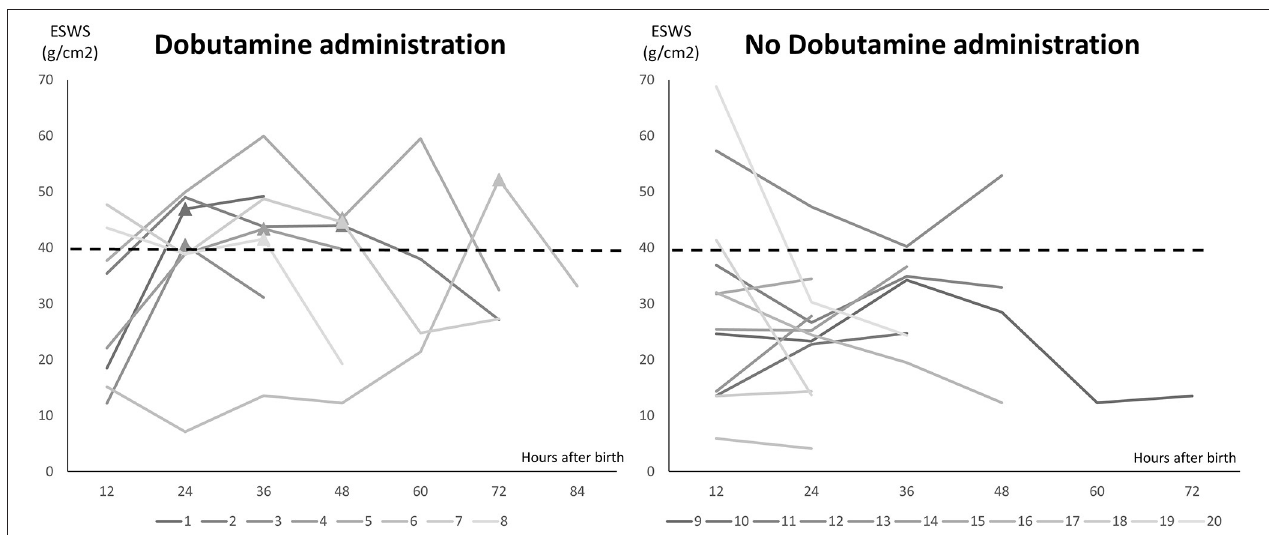
FIGURE 3 | Longitudinal values of ESWS in the management group. Twenty cases were divided into two subgroups: 8 cases with Dobutamine administration and 12 cases without Dobutamine administration. X-axis showed hours after birth, and Y-axis showed the value of ESWS. N stood for the timing of initiating Dobutamine